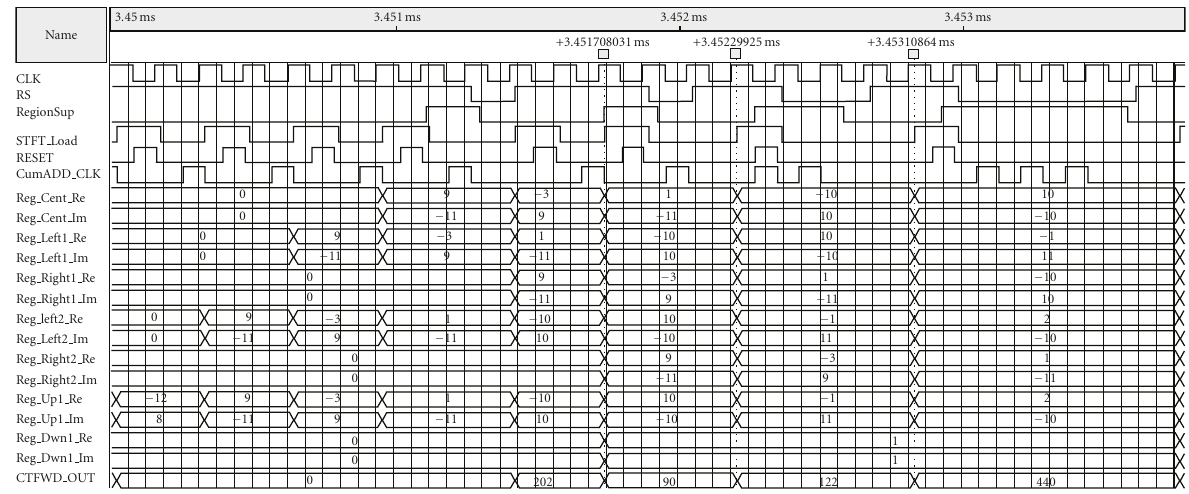
Figure 8: Illustration of the simulation results around the frequency-frequency instant when the region of support is detected.